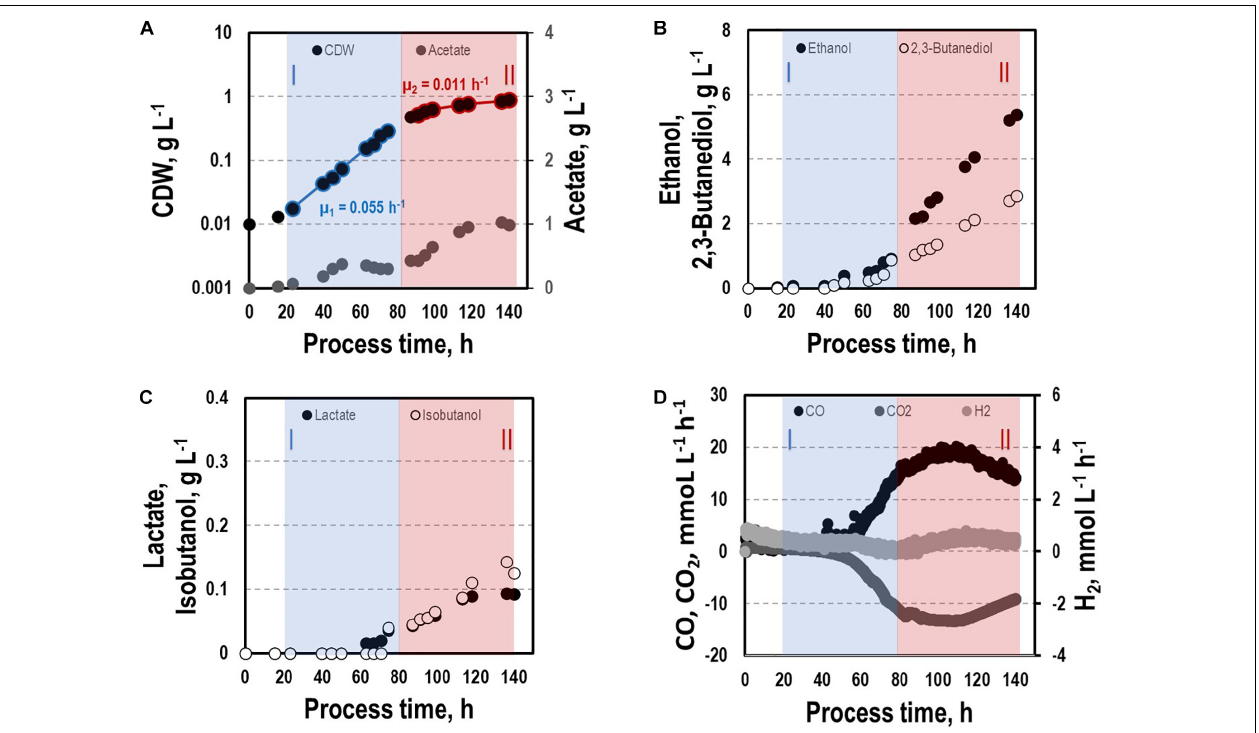
FIGURE 8 | Syngas-based batch cultivation of CLJU[KAIA]:ilvE in a stirred tank bioreactor with a continuous gas supply. Shown are the concentrations of the cell dry weight and acetate (A) , ethanol and 2,3-butanediol (B) , lactate and isobutanol (C) , and the gas uptake (D) ( T = 37 ◦ C; pH = 5.9; VR = 3 L; 500 rpm). Two growth phases I (marked blue) and II (marked red) were identified. Statistical details are given in the Supplementary Material ( Supplementary Table 1